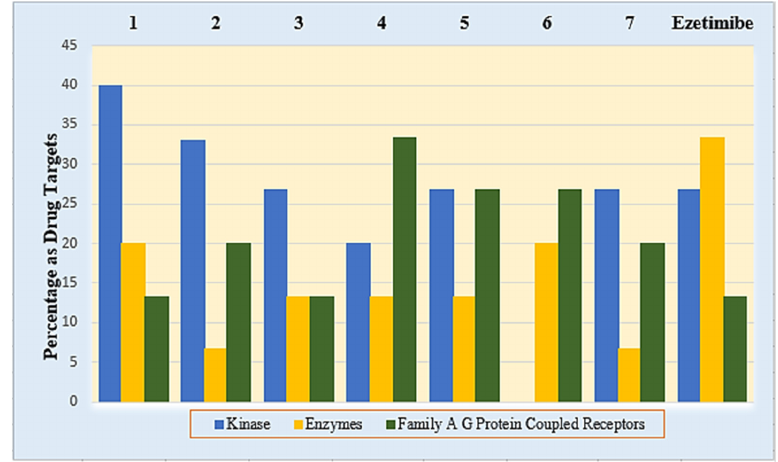
Figure 11. Percentage of kinase, enzymes and family A G protein-coupled receptors as drug targets of compounds 1 – 7 and Ezetimibe as predicted using Swiss Target Prediction.